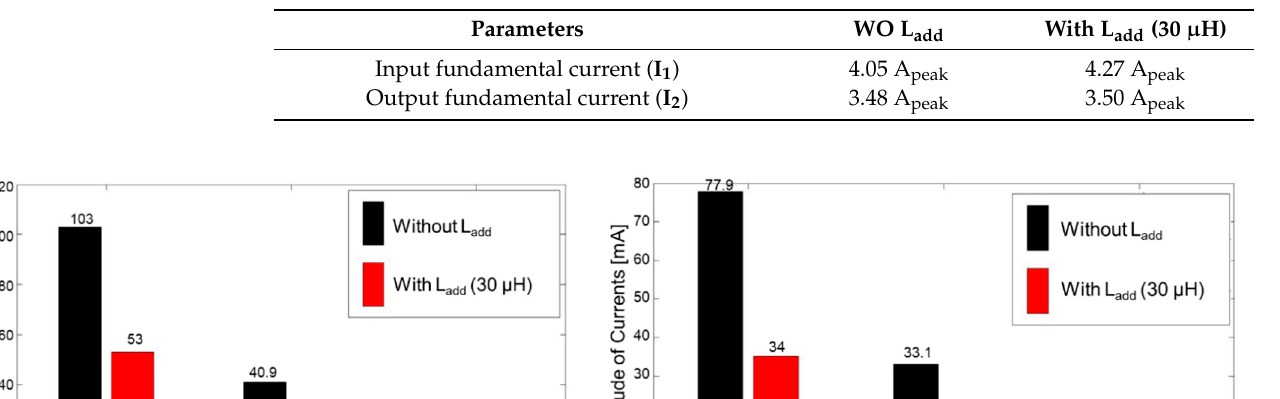
Table 14. Measurement results of the Tx and Rx fundamental current components when operating a 30 W class WPT according to the presence of Ladd (30 µ H ).